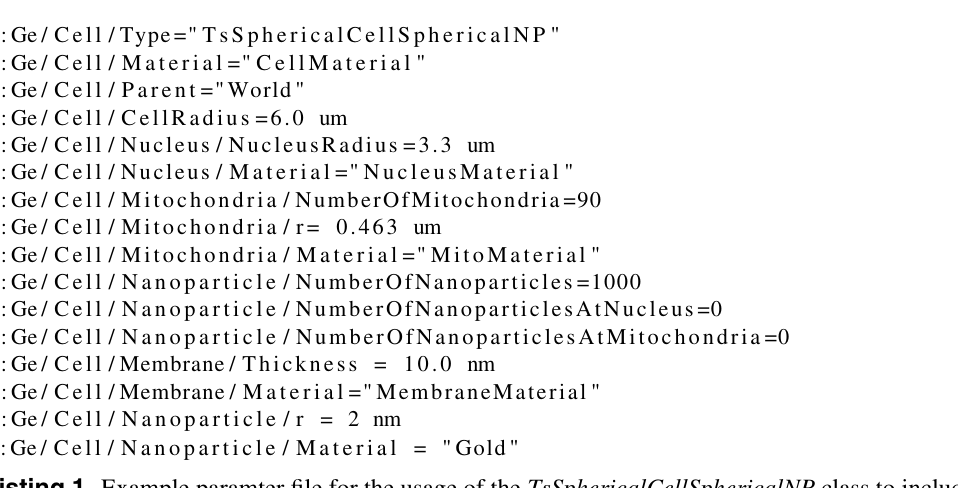
Listing 1. Example paramter file for the usage of the TsSphericalCellSphericalNP class to include nano particles in the cytosol during simulations with Topas